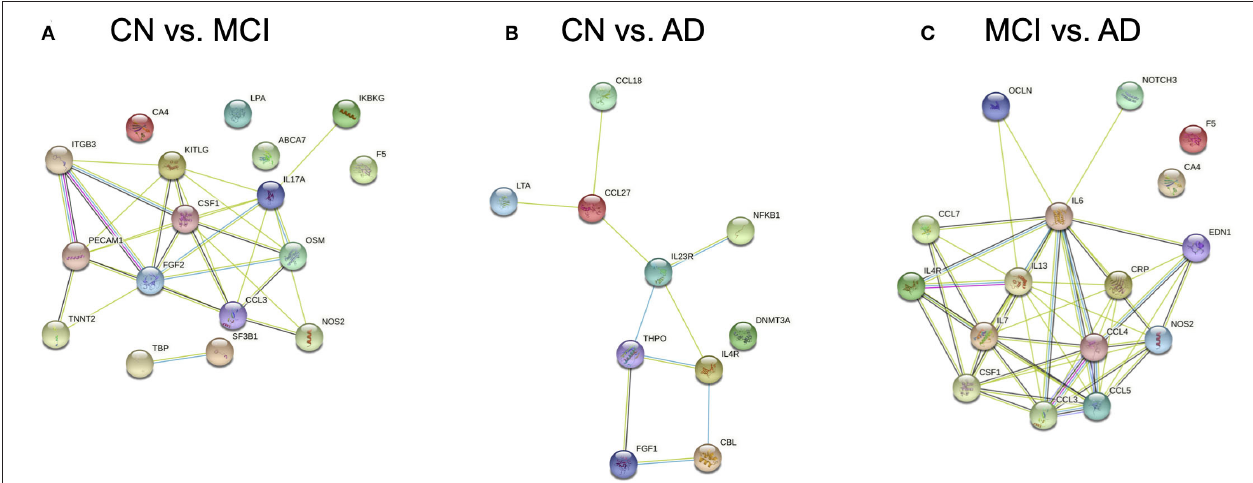
FIGURE 3 | Protein-protein association networks constructed using the Search Tool for the Retrieval of Interacting Genes/Proteins (STRING) database. Proteins displayed are expressed from genes identified by Boruta from pairwise comparisons between (A) cognitively normal (CN) control and mild cognitive impairment (MCI), (B) CN and Alzheimer’s Disease (AD), and (C) MCI and AD subjects.